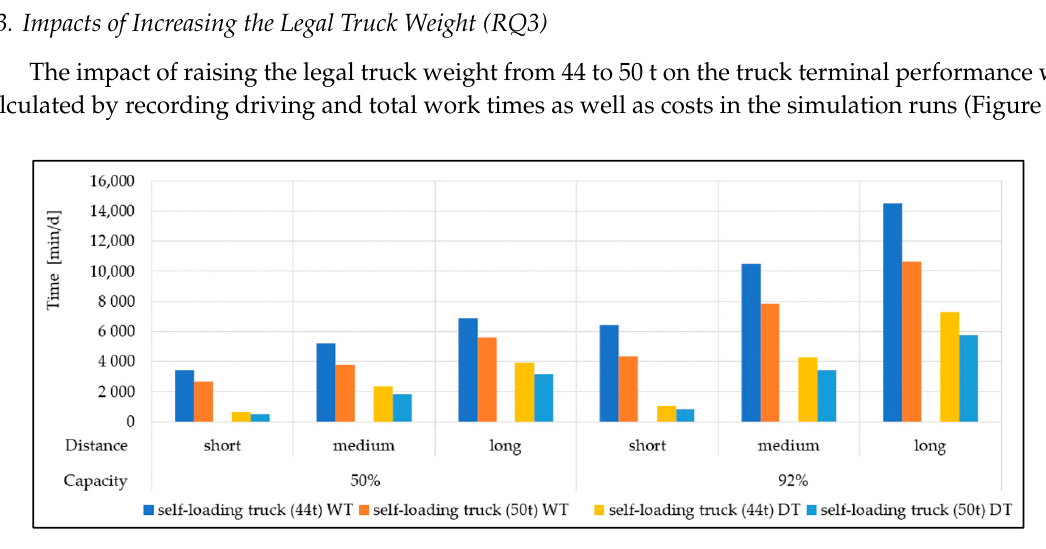
Figure 11. Driving time (DT) and total work time (WT) of self-loading trucks with 44 and 50 t gross vehicle weight for the short, medium and long delivery time scenario and two (50% and 92% of the maximum terminal capacity) transshipment volume scenarios (min / d: minutes per day).